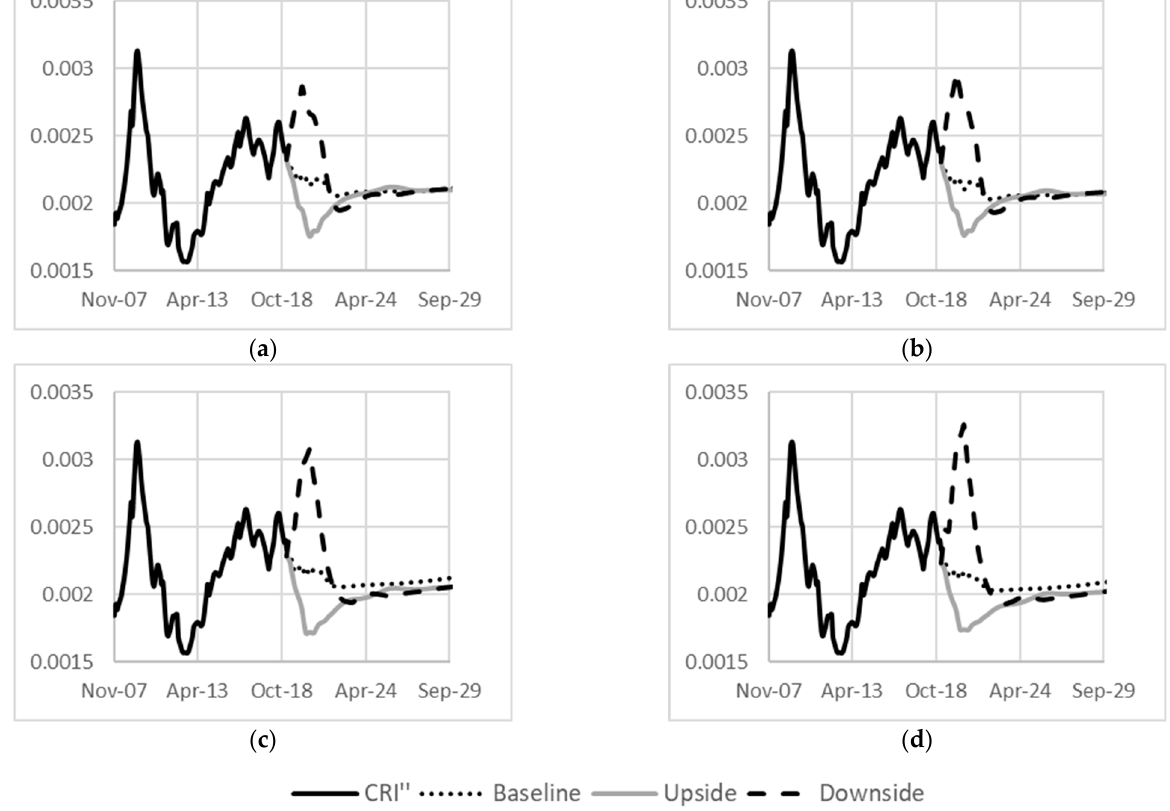
Figure 4. Forecasted 𝐶𝑅𝐼′′ for PCR, GLM-PCR, REG and GLM with baseline, upside, and downside macroeconomic sce- narios. ( a ) PCR; ( b ) GLM-PCR; ( c ) REG; ( d ) GLM-REG.